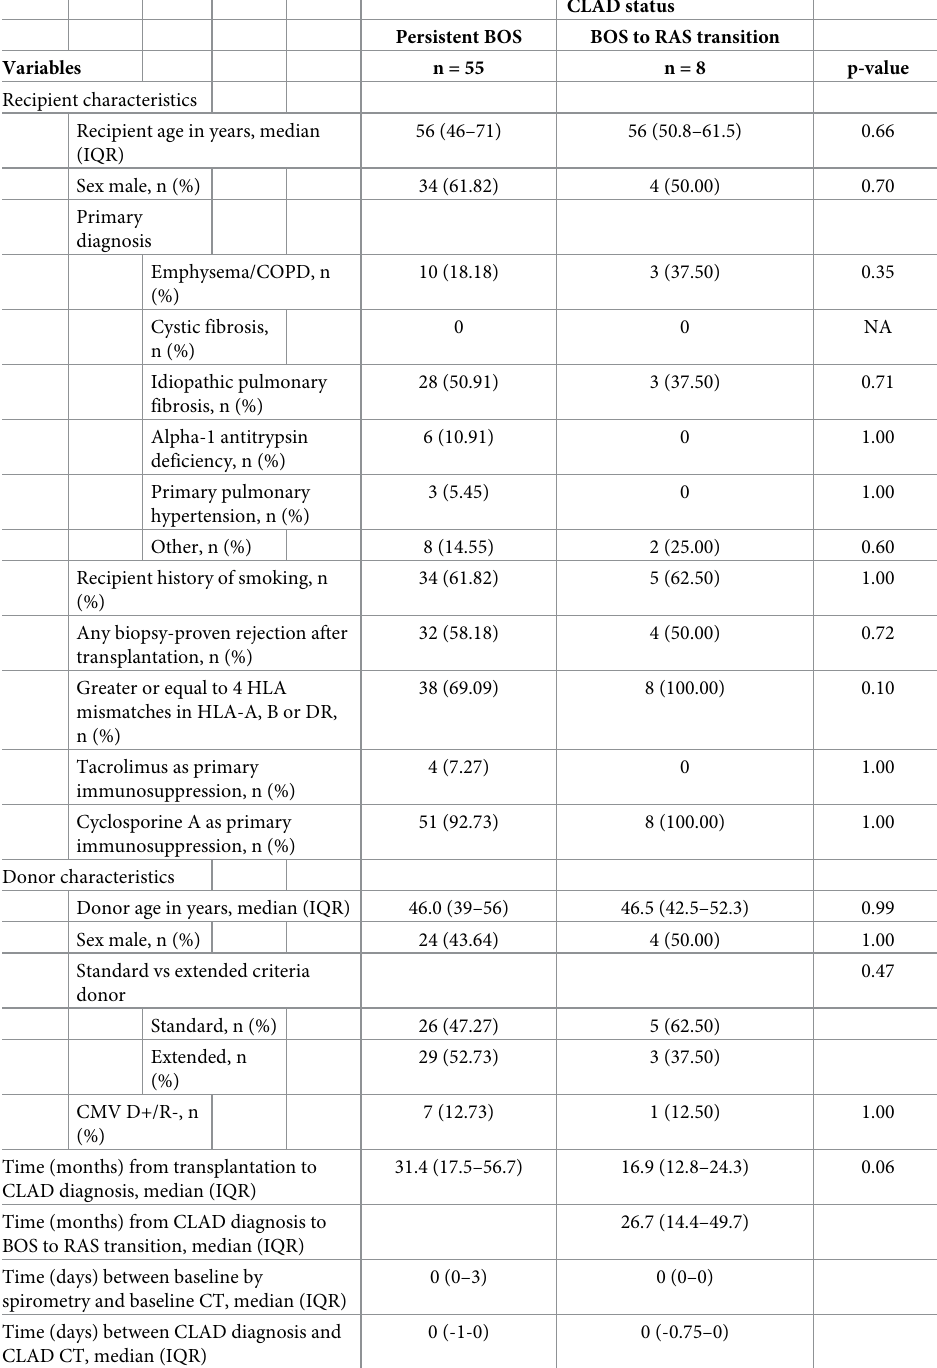
Table 1. Recipient and donor characteristics, time to CLAD onset and BOS to RAS transition.